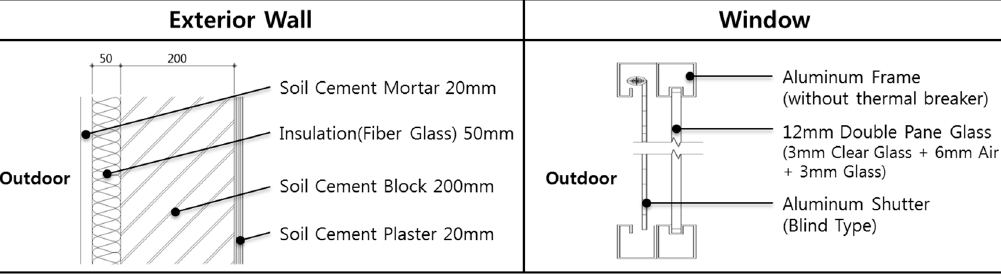
Figure 2. Exterior wall and window structures of actual houses.